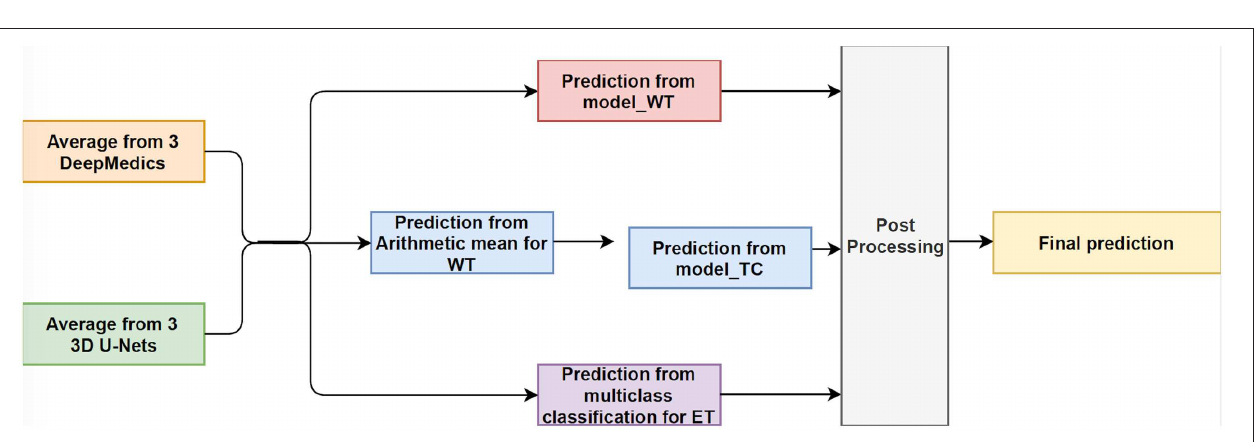
FIGURE 7 | The workflow of Fusion Classification method. For post processing step, we classify the voxels into three classes with background, whole tumor, tumor core, and necrosis & non-enhancing tumor in decreasing order of priority. For example, if a voxel is classified into both whole tumor and tumor core, we give the final label as that of tumor core according to the preference mentioned